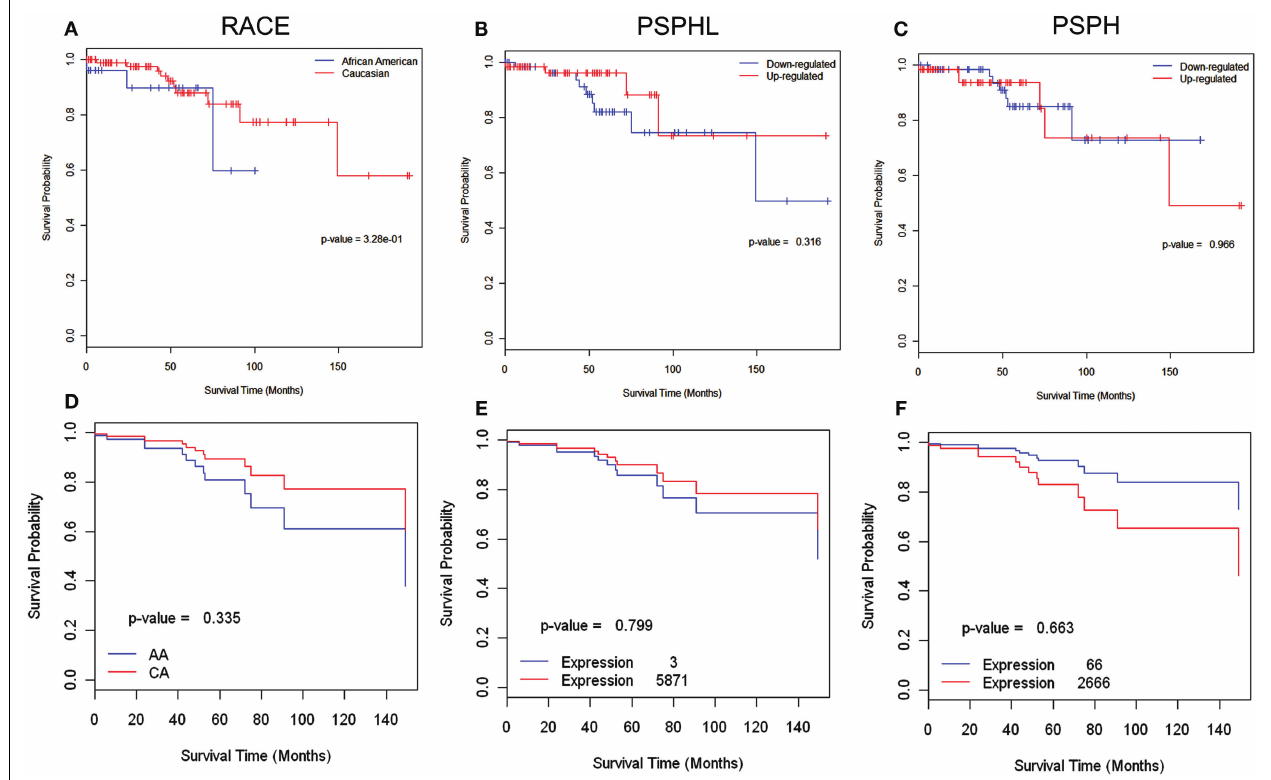
are not statistically significant due to small number of events available for the analysis. (D–F) Cox regression analysis of same data showing estimated survival curves: (D) for AA and CA, (E) minimum and maximum signal levels of PSPHL and (F) minimum and maximum signal levels of PSPH.